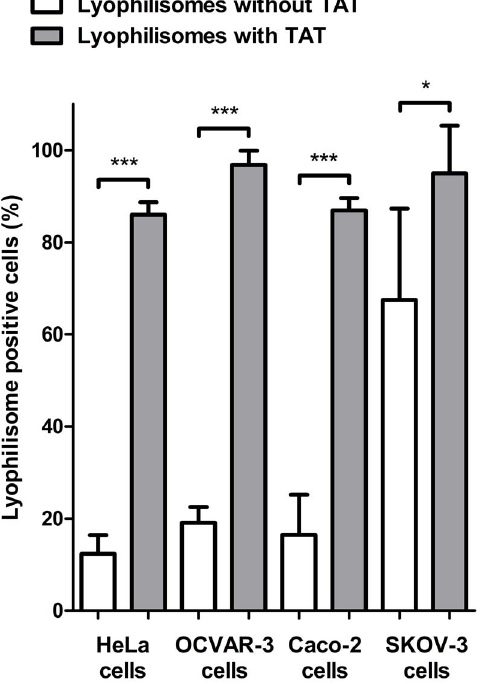
Figure 2. Cellular binding and internalization of unmodified lyophilisomes and TAT-conjugated lyophilisomes. HeLa, OVCAR- 3, Caco-2 and SKOV-3 cells incubated with TAT-conjugated and unmodified lyophilisomes resulted in 86 6 3% and 12 6 4%, 87 6 3% and 16 6 8%, 97 6 3% and 19 6 3%, and 95 6 10% and 67 6 20% lyophilisome-positive cells, respectively. TAT = trans-activating